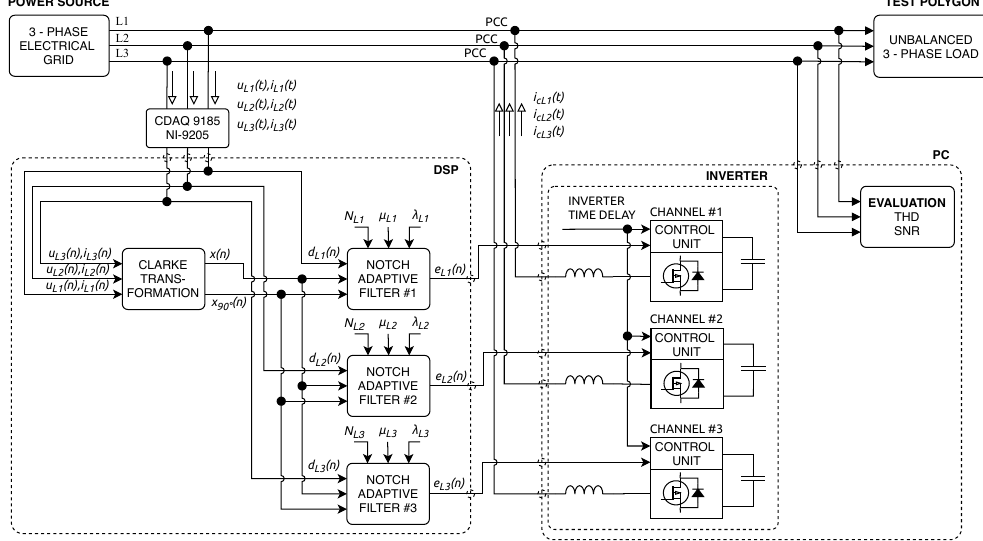
Figure 13. Simplified schematic diagram of the conducted experiment with simulated inverter.